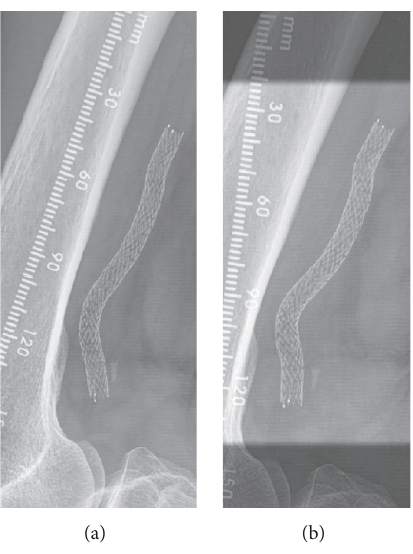
Figure6:X-rayimagesofaBioMimics3Dstentinafemoropopliteal location in a patient with knee bent at 90 degrees, at 1 month (a) and 6 months (b) after implantation, showing sustained stent curvature over